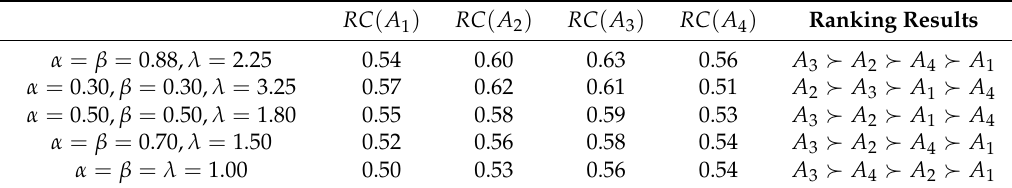
Table 2. The ranking results obtained by different risk preference parameters.